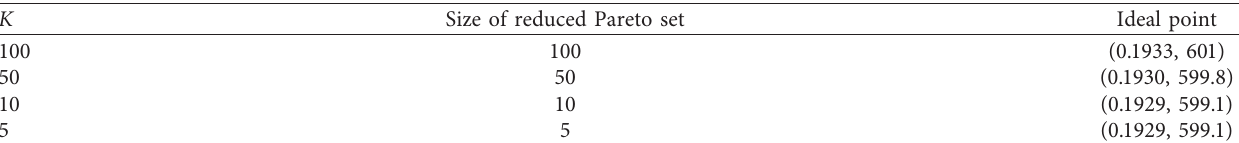
Figure 7: Pareto optimal convergence. (a) Cost ($/h) versus generation. (b) Emission (Ton/h) versus generation. (c) Ideal points versus generation. (d) Nadir points versus generation. Table 5: Implementation of K -means method to reduce the shrink Pareto optimal frontier.